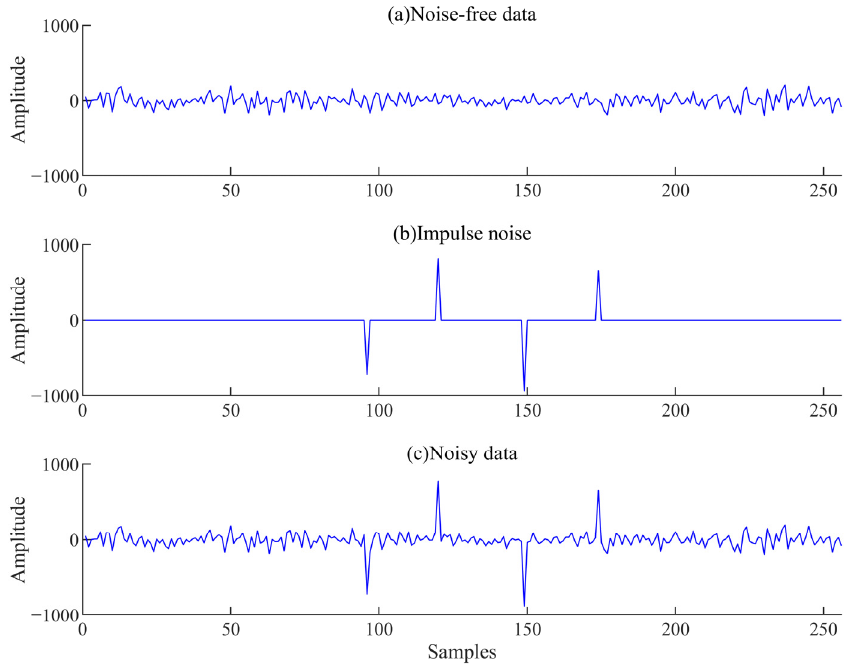
Figure 4. Synthesis of impulse noise. ( a ) Noise-free data, ( b ) impulse noise, ( c ) noisy data.